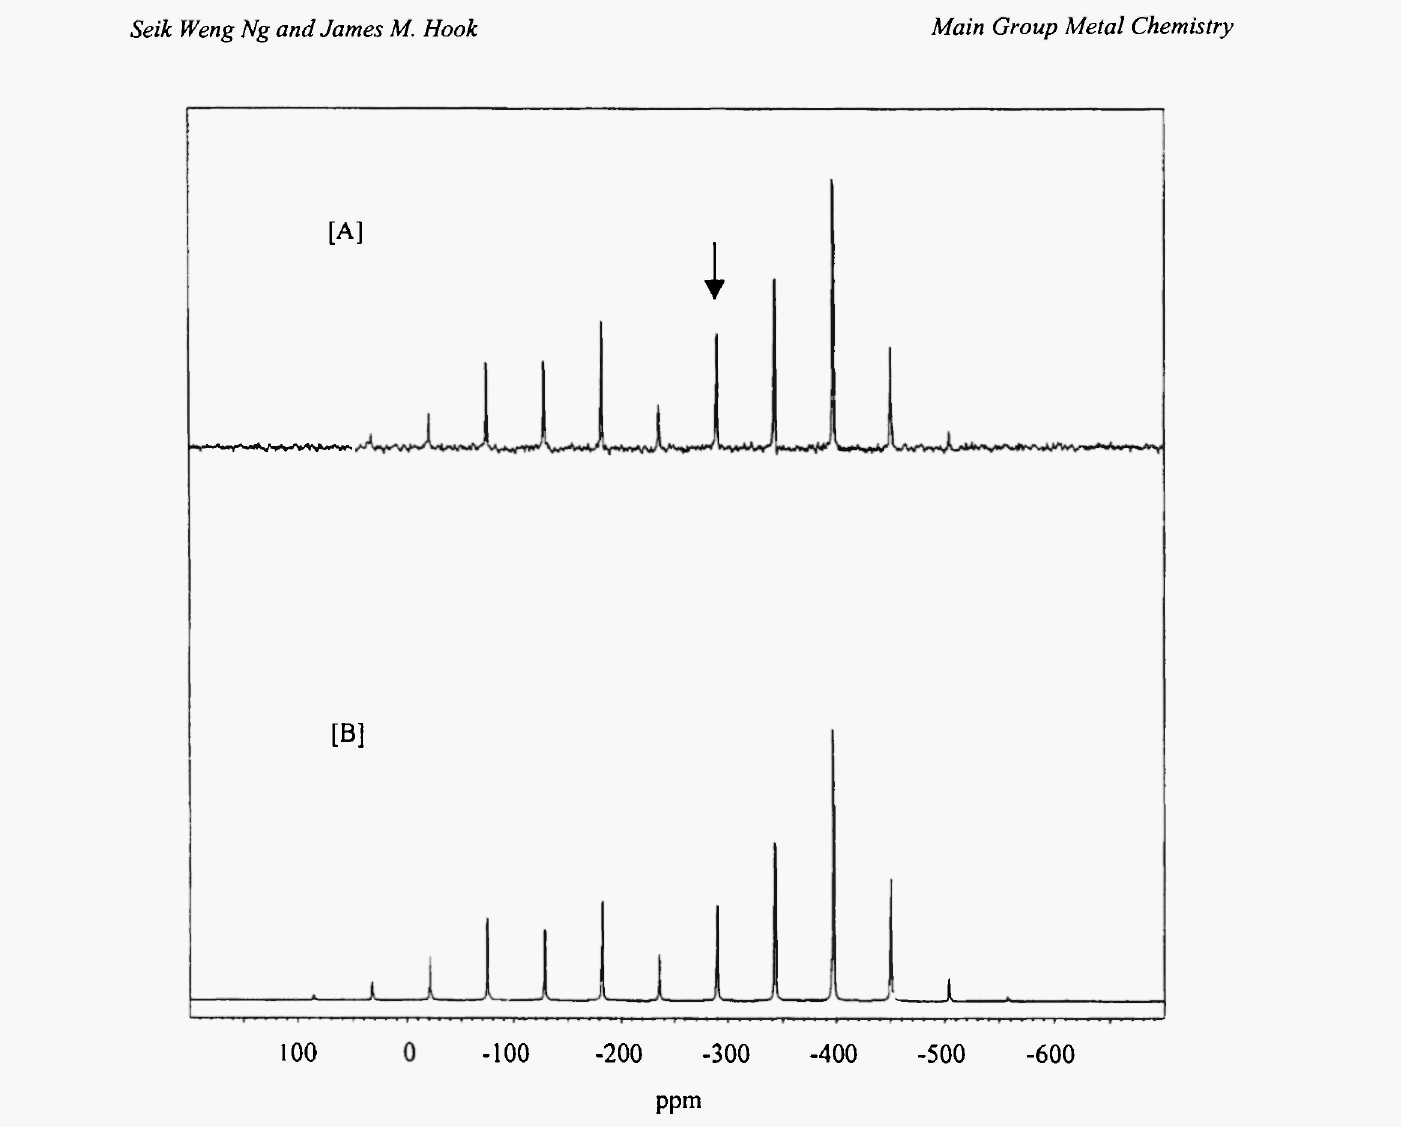
Fig. 4. Solid-state " 9 Sn MAS NMR spectrum of tetramethylammonium bis(trifluoroacetato)- triphenylstannate. [A]: Spectrum measured at 6 kHz with the isotropic peak at -290 ppm marked with an arrow. [B]: Simulated spectrum (see Experimental for